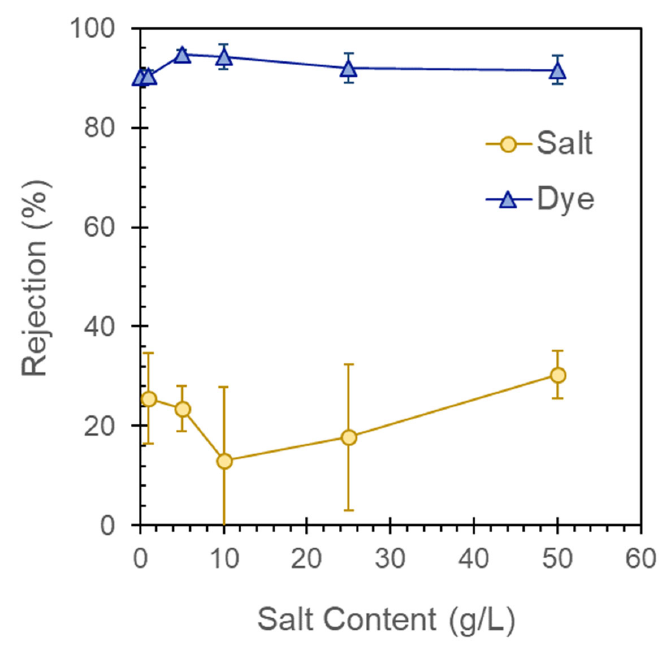
Figure 12. Impact of feed-water salinity on dye- and salt-rejection performance of 2-bilayer GO–PEI-modified CA membrane.